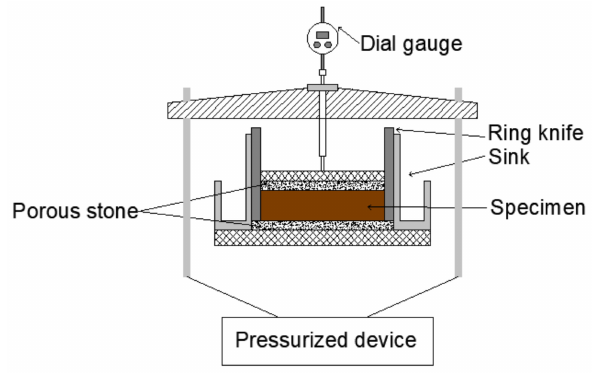
Figure 3. Loaded swelling strain and swelling pressure test